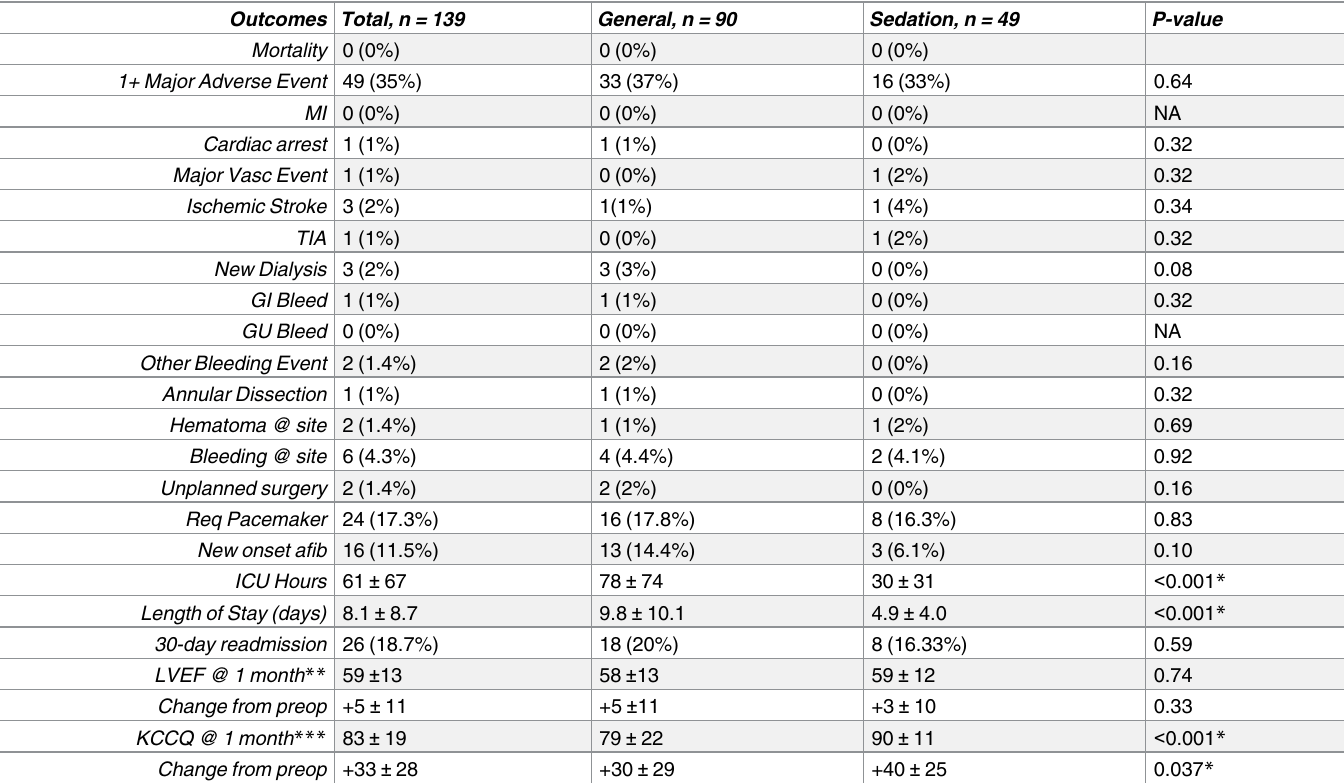
Table 6. Clinical outcomes, excluding Sapien 1